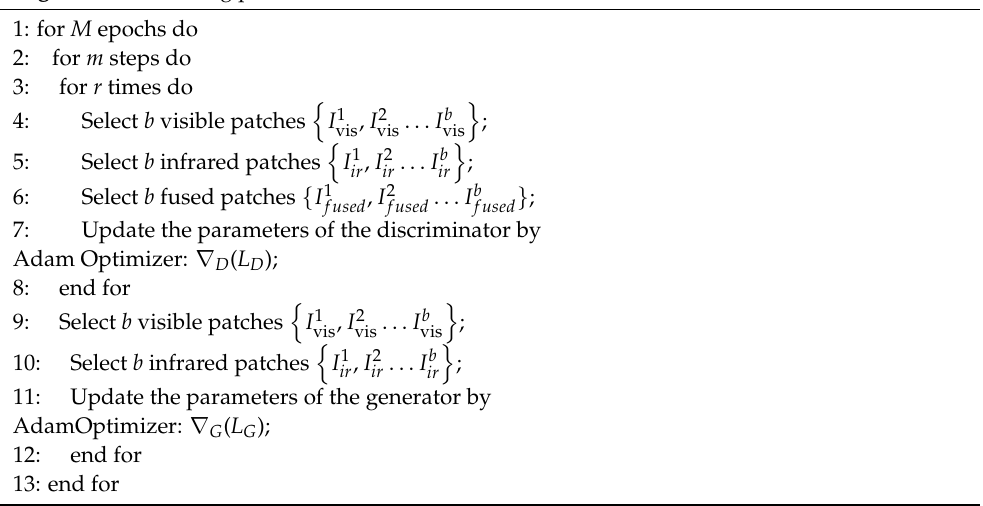
Algorithm 1: Training procedure for